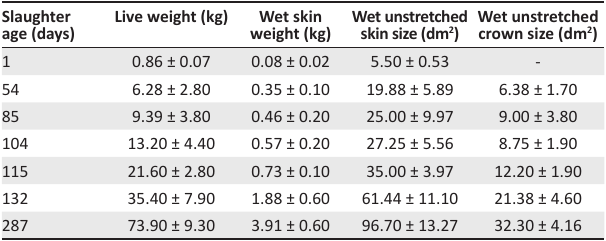
TABLE 4: The wet skin data and the accompanying standard deviations at each slaughter age and slaughter weight.